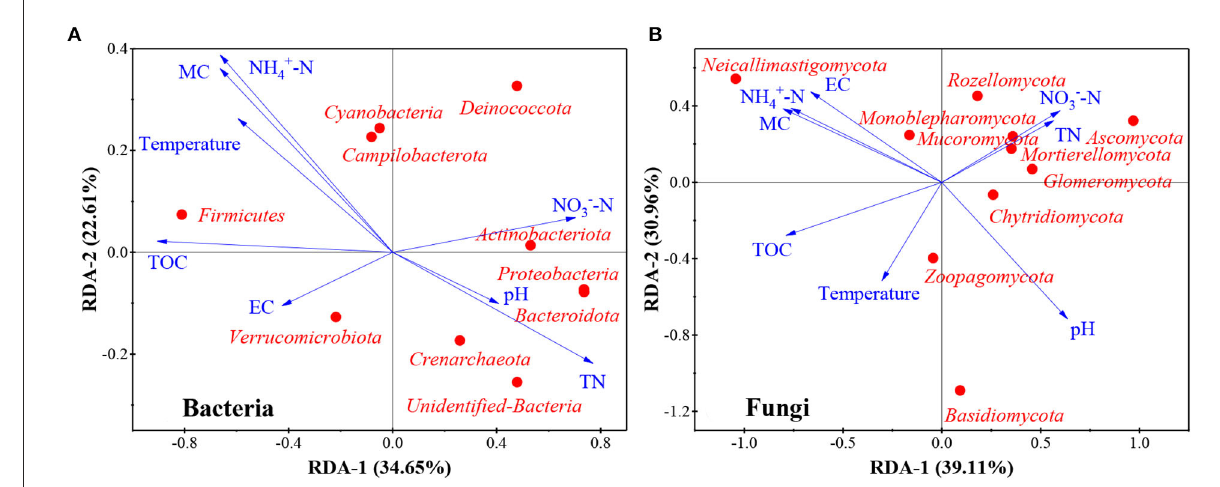
FIGURE7 RDA ordination biplots between bacterial (A) , fungal (B) communities and physico-chemical